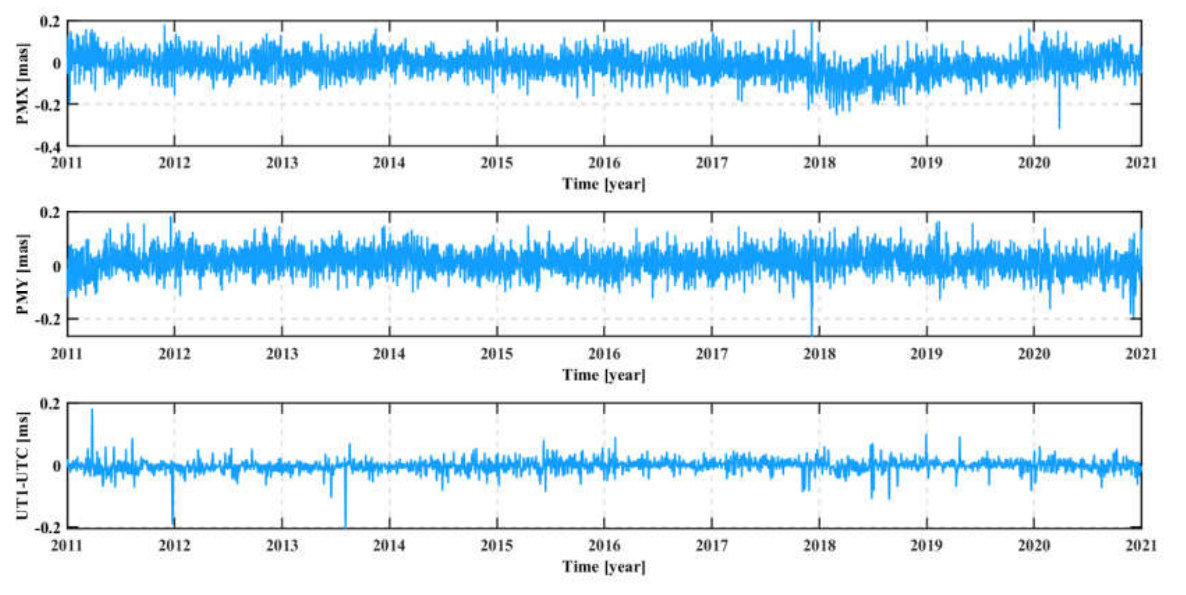
Figure 2. Daily solutions of residual polar motion and UT1-UTC based on VLBI observations from 2011 to 2020 after subtracting daily ERP series provided by IERS; PMX, PMY represent the x and y components of polar motion series respectively, UT1-UTC is universal time.